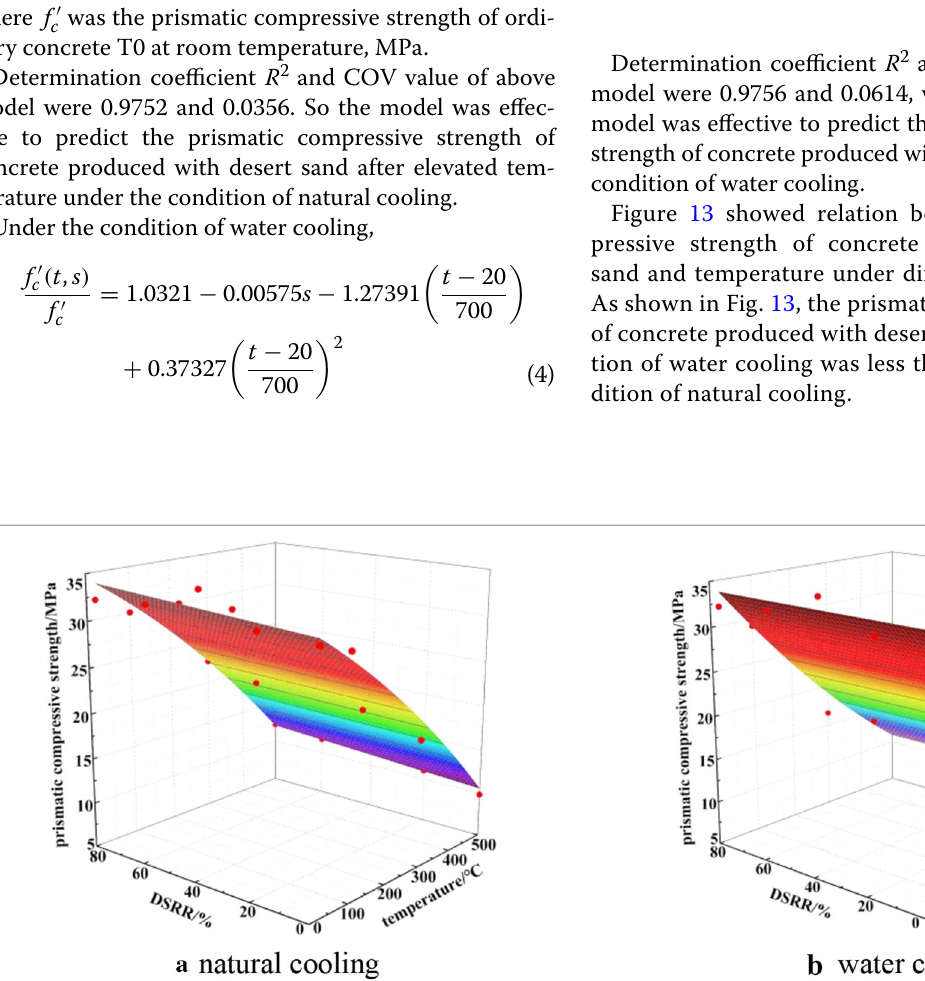
Fig. 12 Comparision of prismatic compressive strength between the predicated results from the regression model and experimental results of concrete produced with desert sand.